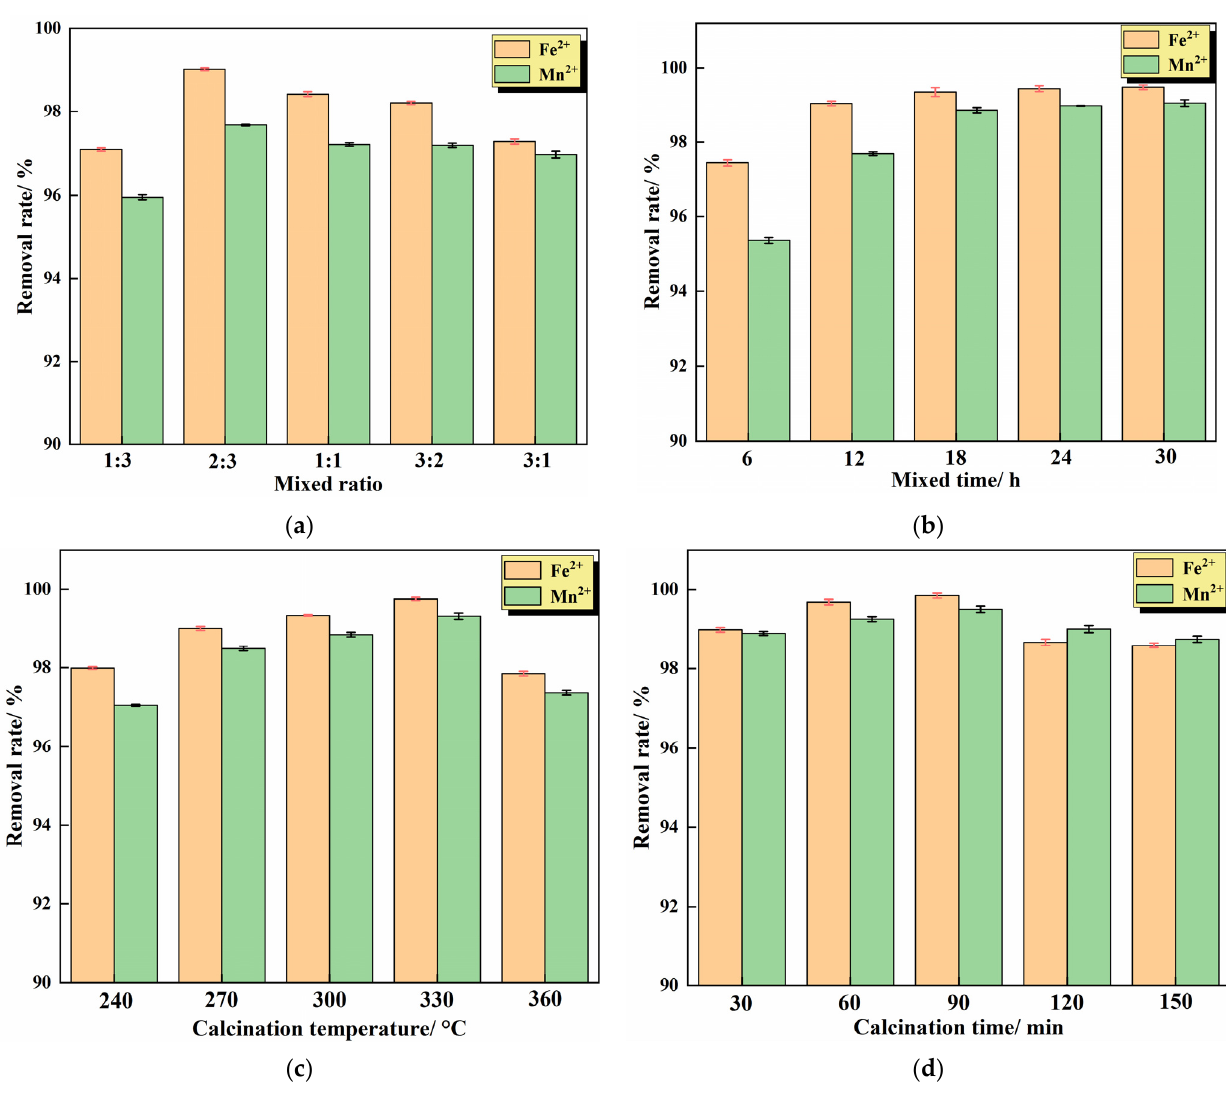
Figure 3. Preparation conditions of the IHA/TM composite particles: ( a ) mixing ratio; ( b ) mixing time; ( c ) calcination temperature; and ( d ) calcination time. (Other conditions are subject to optimal conditions).